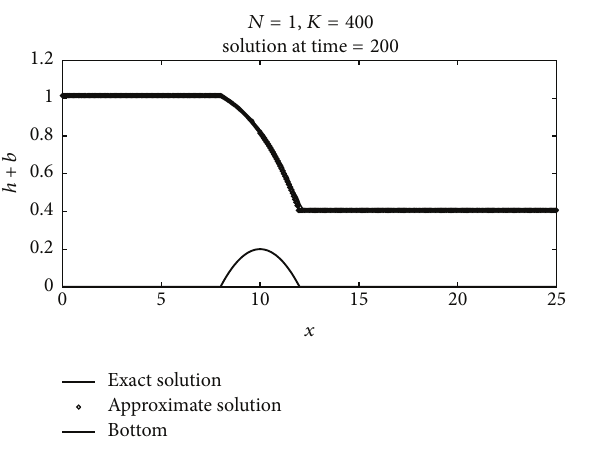
Figure 6: Transcritical flow without shock over a bump.